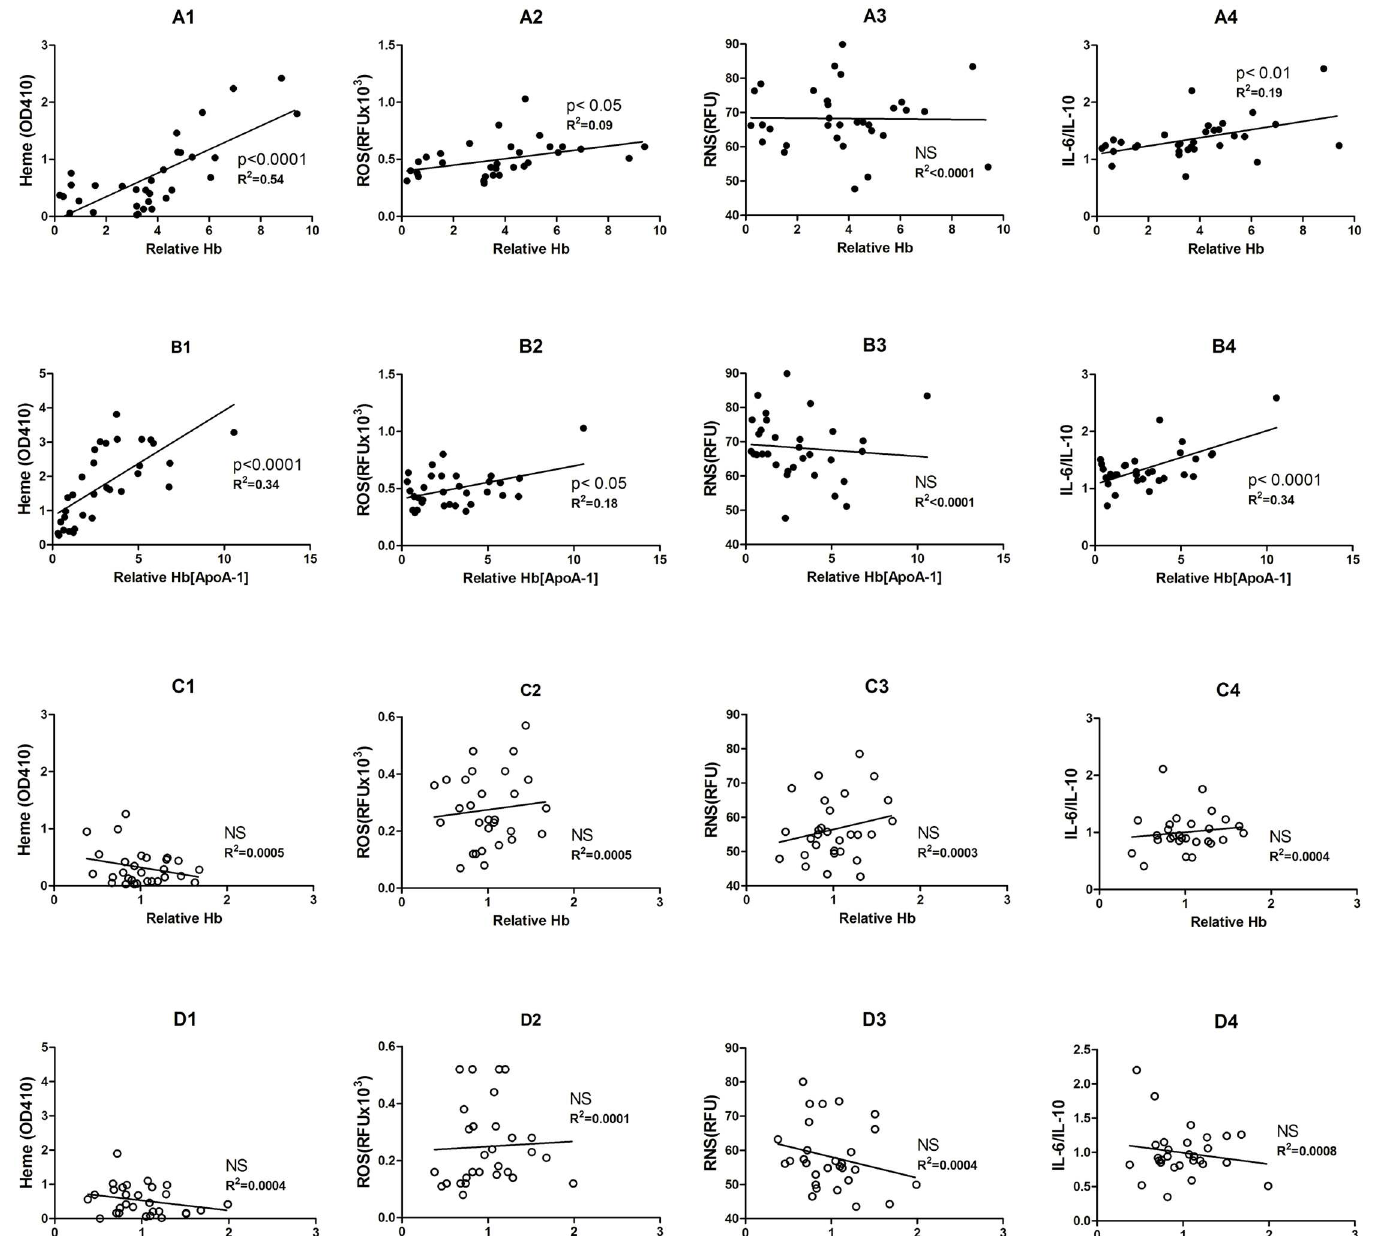
Fig 2. Hemoglobin (Hb) concentrations associated with HDL were positively correlated with heme, reactive oxygen species (ROS) level and IL-6/ IL-10. RelativeHb levels in the plasma (A1–A4 and C1–C4). RelativeHb [ApoA-1] = Hb associated with ApoA-1 particles from HDL (B1–B4 and D1–D4). Fig A1-A4 and B1-B4 present the data from the SCD group (n = 32) and Fig C1-C4 and D1-D4 are those from healthy donors (n = 28). Linear regressionwas performed individually and and p values and R 2 values are shown in the Figs. (NS = not